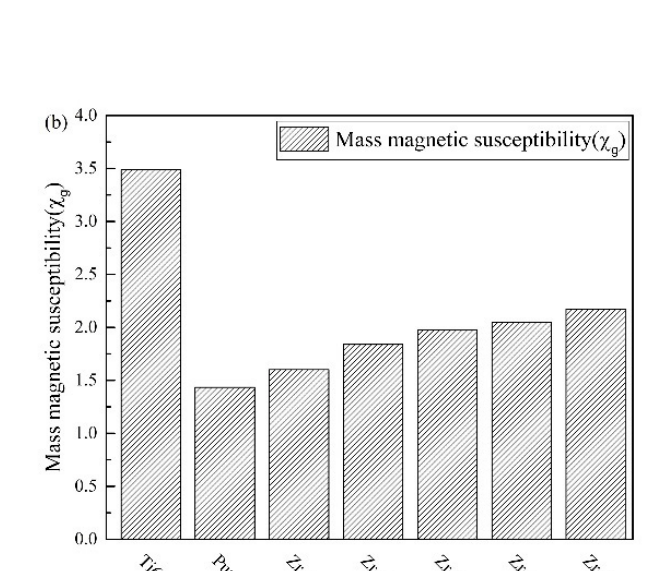
Table 2. Zr, Nb, Ti ion concentration release from pure Zr, pure Ti and the Zr-16Nb-xTi alloys.